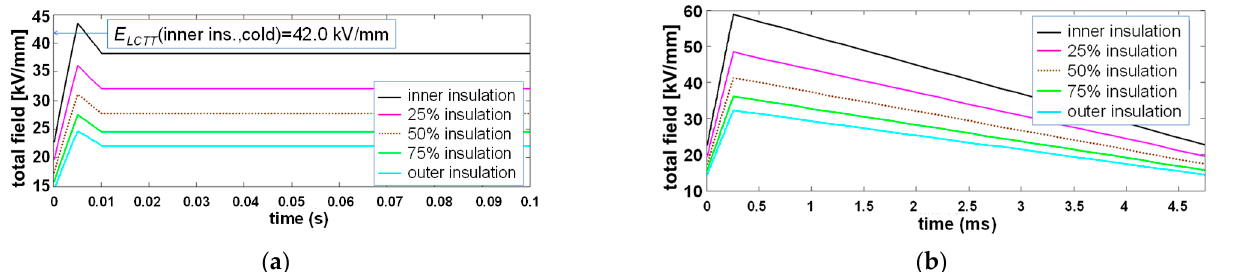
Figure 7. ( a ) Total electric field vs. time at 5 locations within the insulation of the 500 kV DC-XLPE cable in cold (=un- loaded) conditions during ( a ) the worst case TOV (E LCTT = maximum field during load cycle type test after [12]); ( b ) a SSISP with U P = U P 2, S,max = 2.4 U 0 . a = 0.0425 K − 1 , b = 0.032